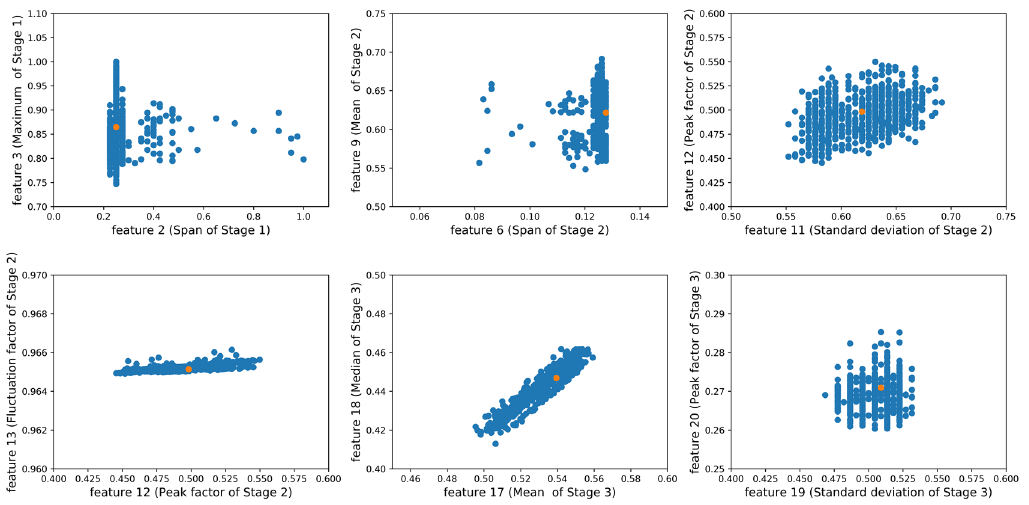
Figure 7. Class center of features.